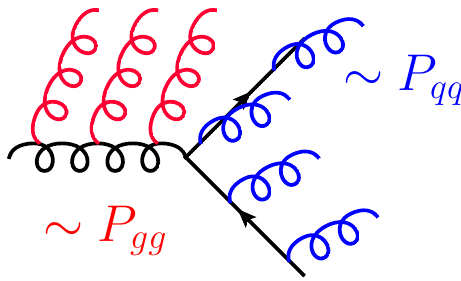
Figure 6 . The g ! b (cid:22) b splitting, dressed with extra gluon radiation. In the collinear limit, radiation o(cid:11) the parent gluon (red) corresponds to factors of P gg , while radiation o(cid:11) the quarks (blue) to factors P qq